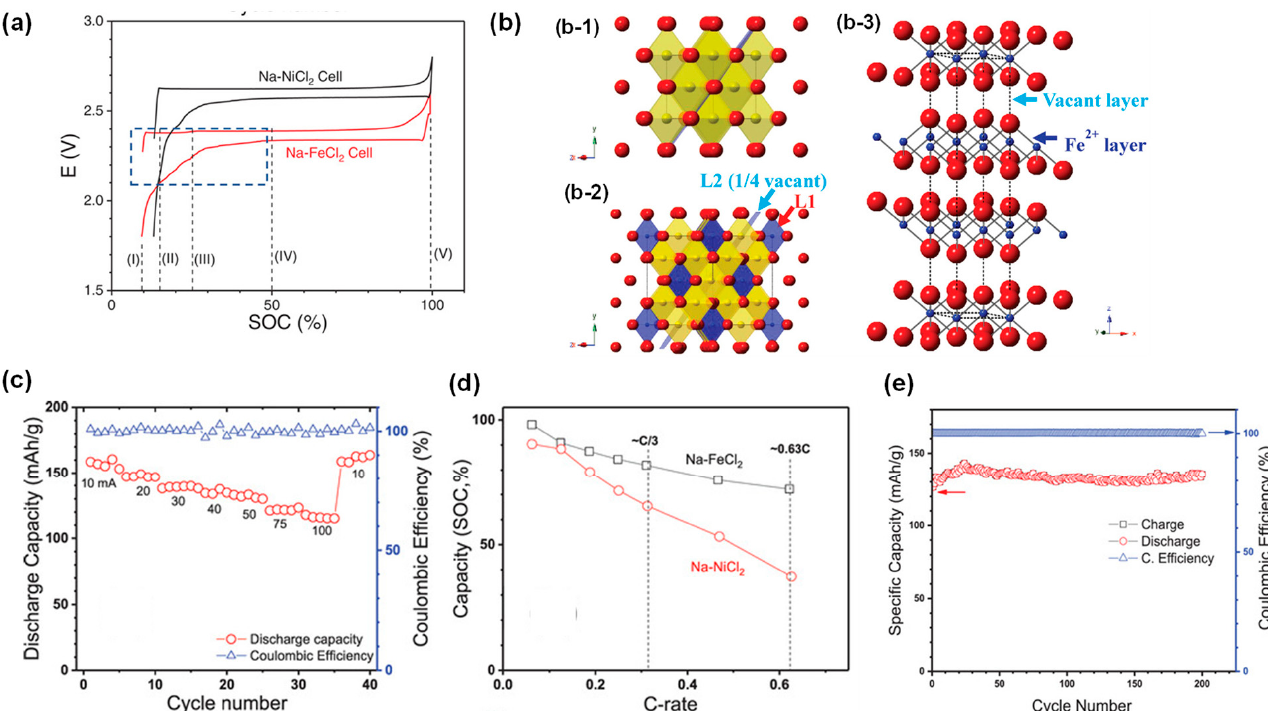
Figure 8. ( a ) Typical voltage vs. SOC plots of Na-NiCl 2 and Na-FeCl 2 cells. ( b ) Crystal structures of three key phases, ( b-1 ) NaCl, ( b-2 ) Na 6 FeCl 8 , and ( b-3 ) FeCl 2 , involved in the charging process of a Na-FeCl 2 battery. The red spheres represent Cl − ions, while yellow and blue octahedra are, respectively, six-coordinated NaCl 6 and FeCl 6 . The (111) plane is indicated by light blue for NaCl and Na 6 FeCl 8 . ( c ) Rate performance of a Na-FeCl 2 battery operated at 190 ◦ C. ( d ) The evolution of normalized capacity (SOC, %) as a function of C-rate for Na-FeCl 2 batteries. The data of Na-NiCl 2 batteries (red points and line) were included as references. ( e ) Stable long-term cycling performance in terms of specific capacity of Na-FeCl 2 batteries with 10 wt.% Ni as cathode additive (adapted with the permission from